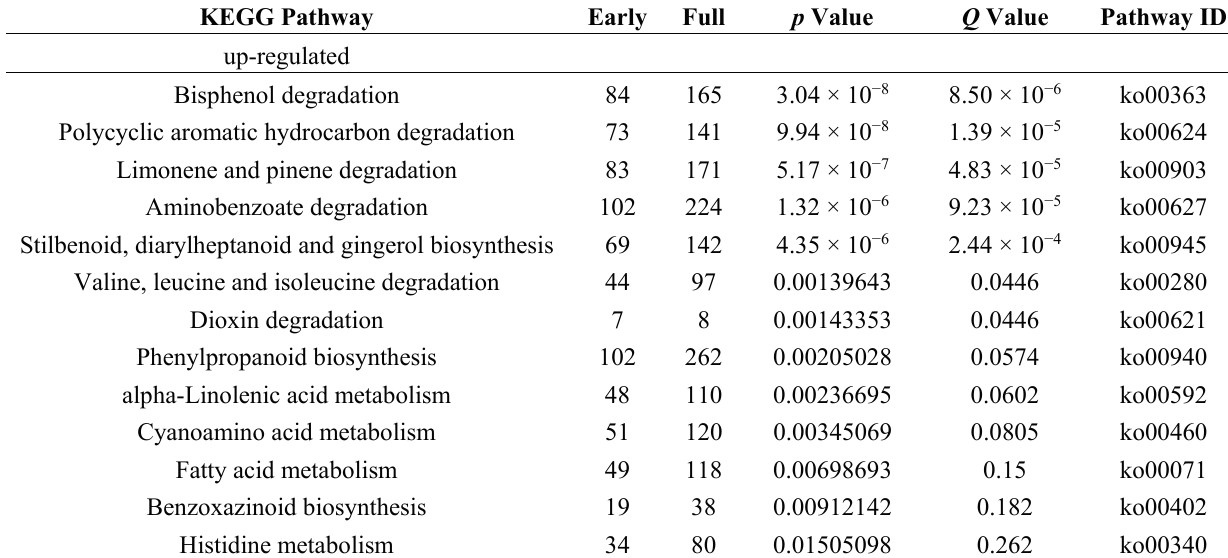
Table 2. The first 15 up- and down-regulated enriched